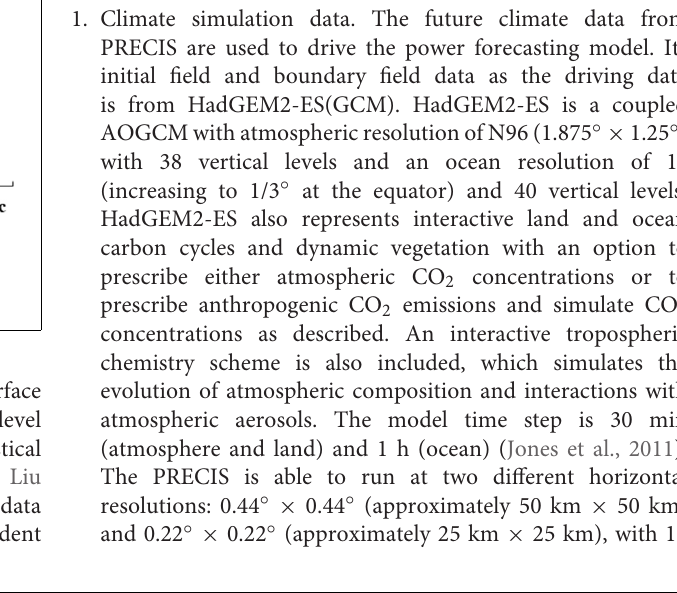
Yan, 2017). According to correlation analyze, Near-surface temperature, Surface relative humidity and Mean sea level pressure are selected as independent variables in statistical downscaling (Wood et al., 2004; Perkins et al., 2007; Liu et al., 2011). The meteorological station precipitation data are selected as dependent variable. Then, the independent